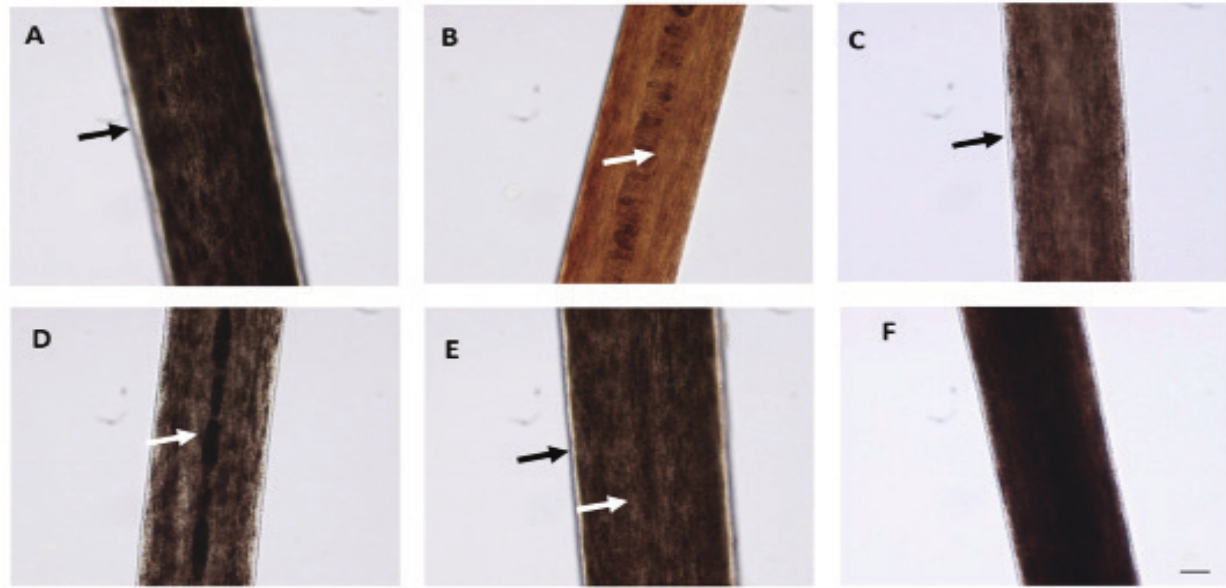
Figure-II: Representative images of qualitative parameters in the cortex, medulla and cuticle of hair in Factory workers (FW). Scale 20 µ. Black arrow Cuticle, White arrow